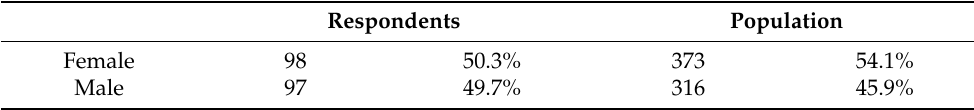
Table 3. Comparing respondents with the